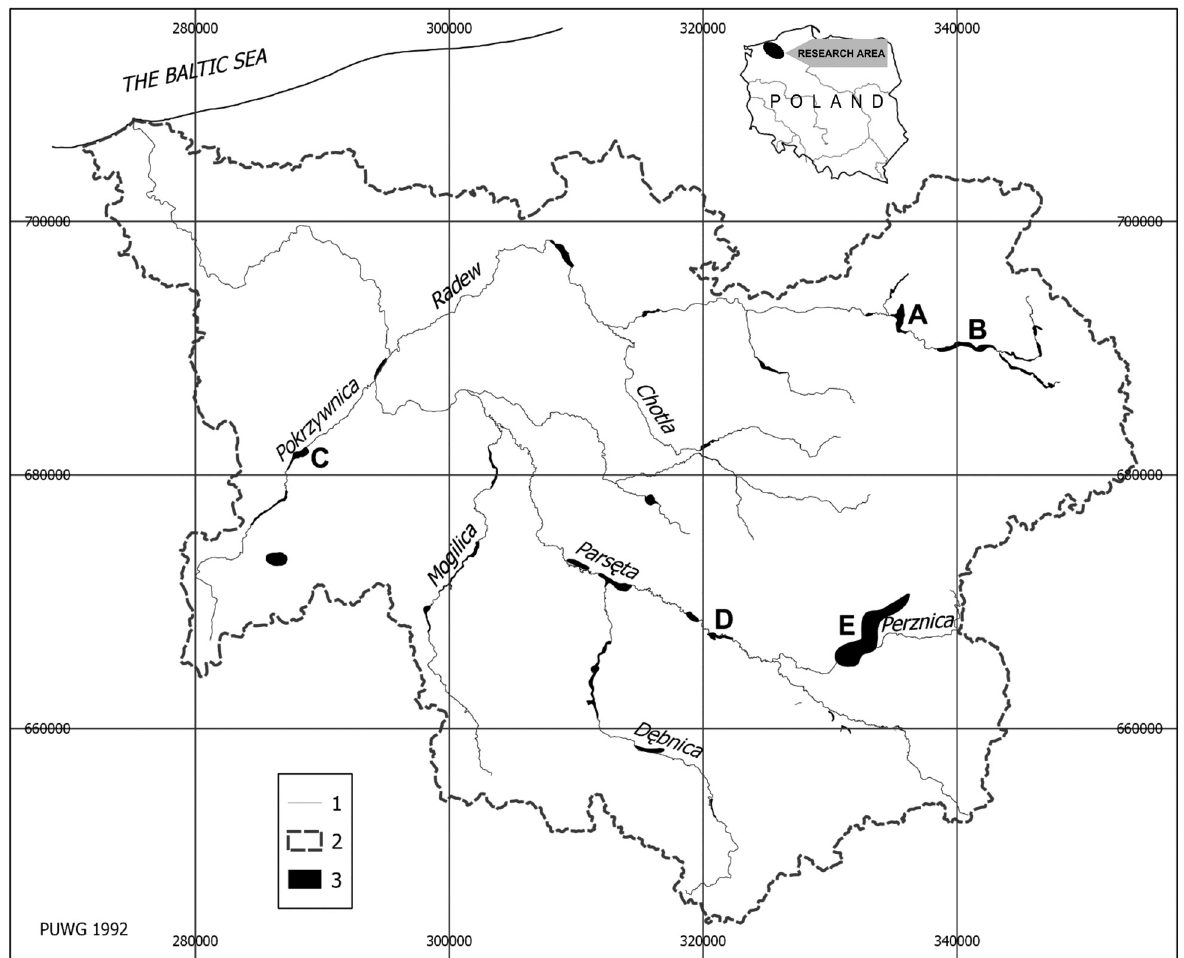
Fig. 1. Location of irrigated areas in the Parsęta